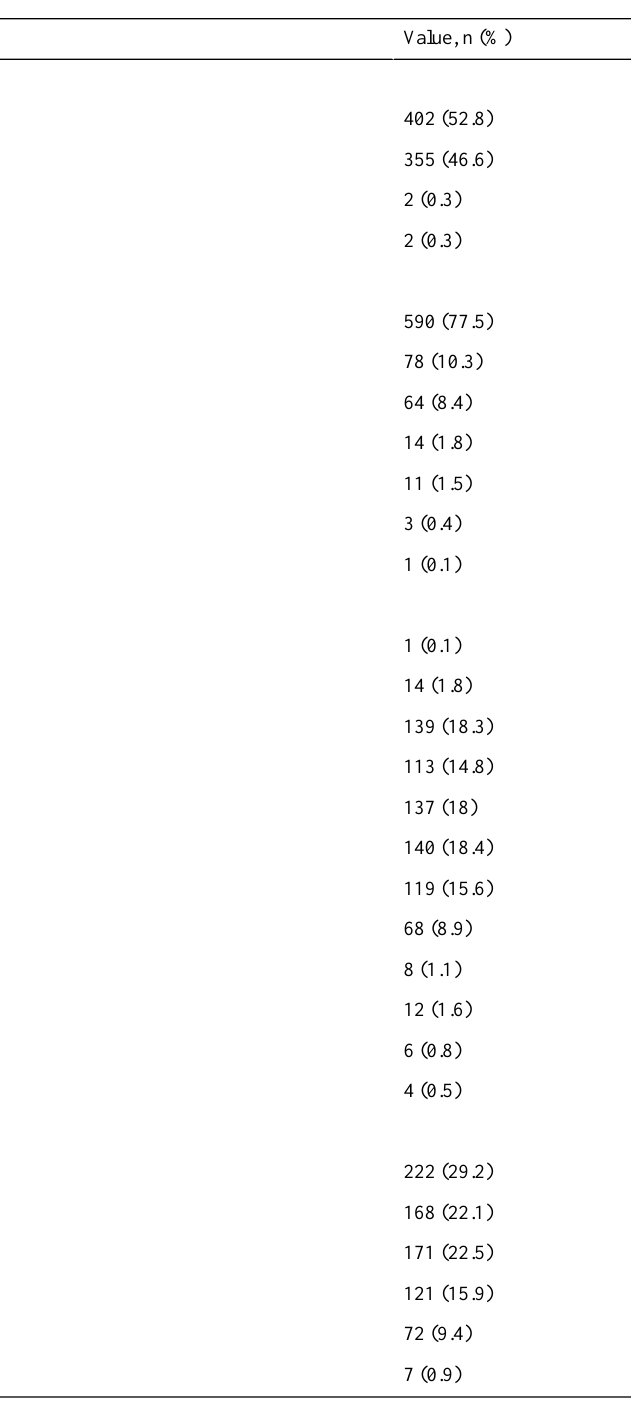
Table 1. Participant characteristics